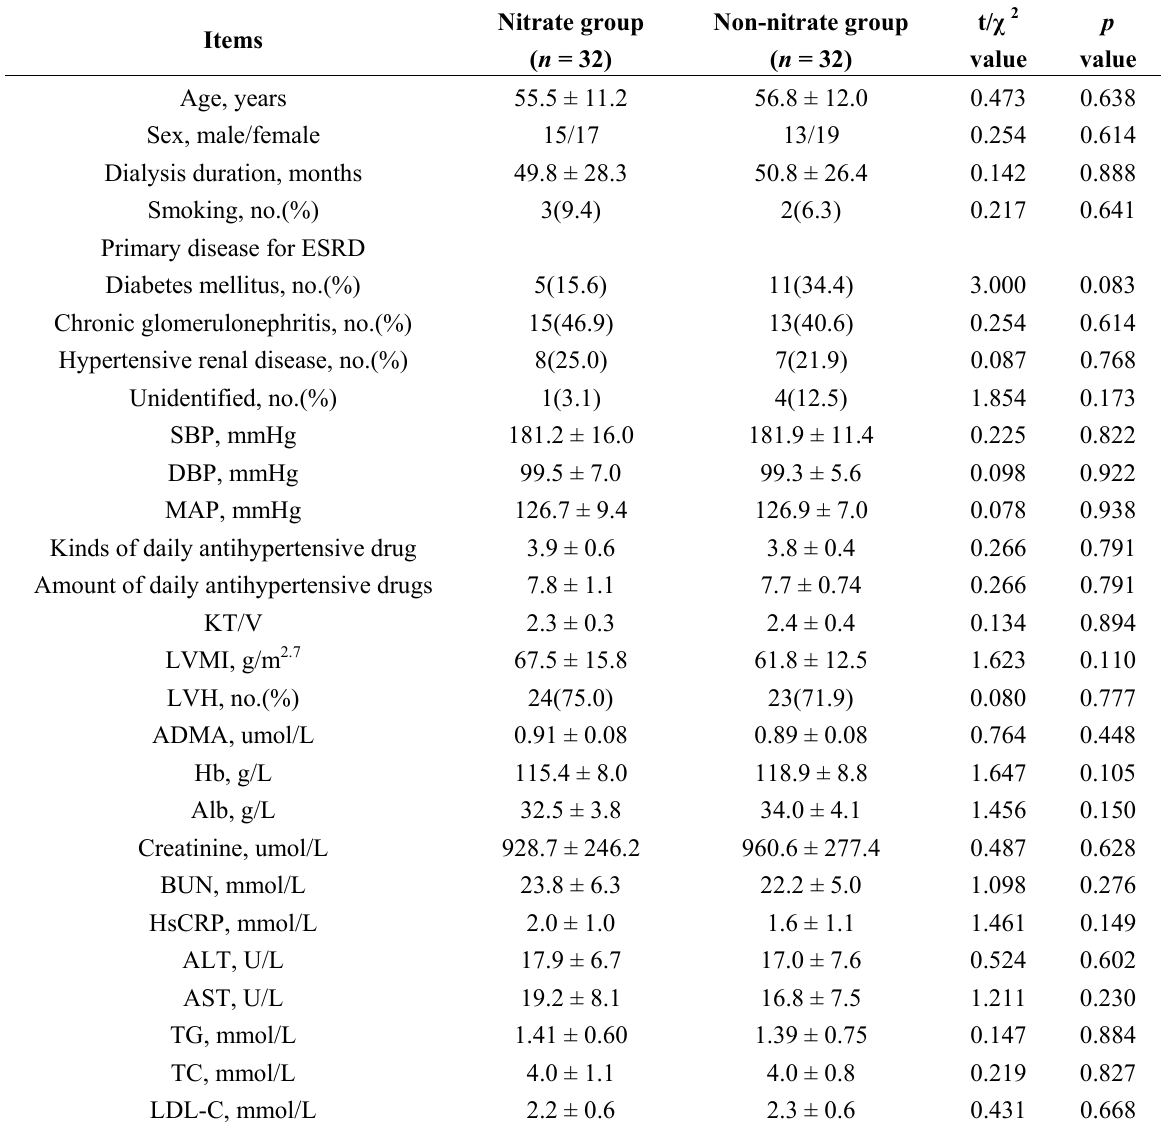
Table 1. Characteristics of both study